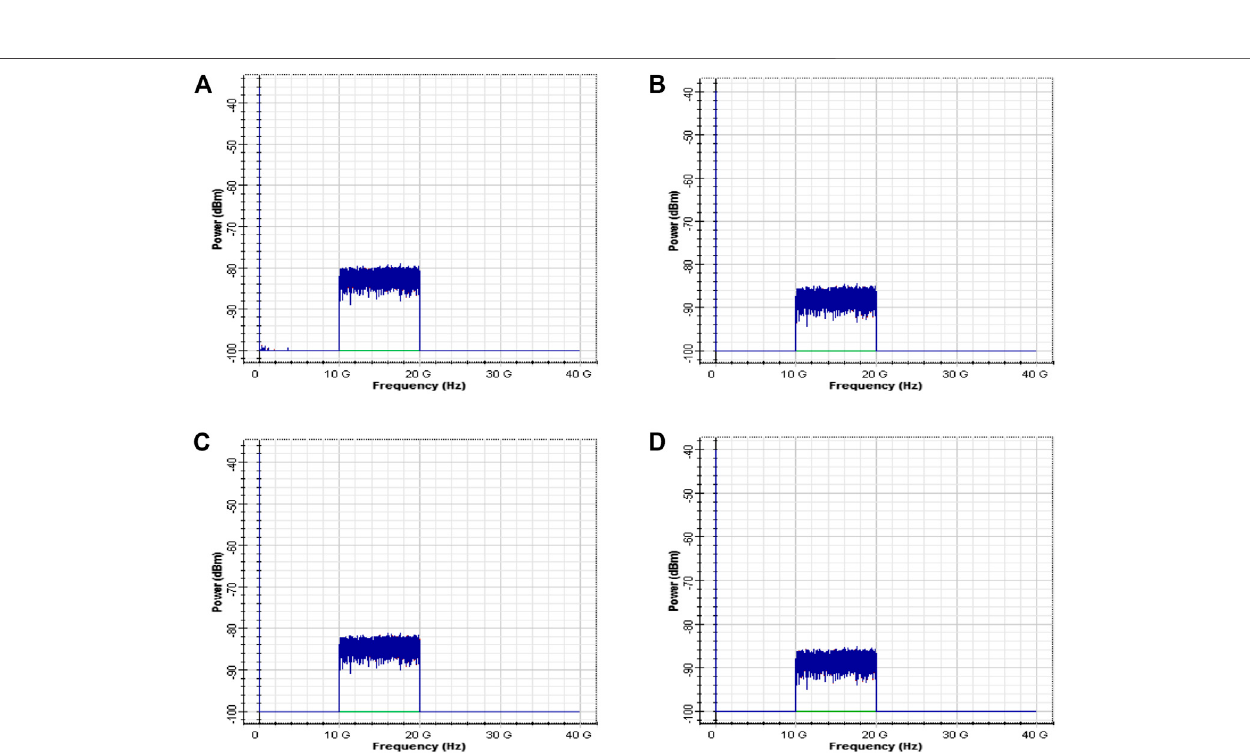
FIGURE7| RFpowerafter32 kmrangefor193.1 THzchannel (A) HG01modeand (B) HG03mode;for193.2 THzchannel (C) HG01modeand (D) HG03mode.